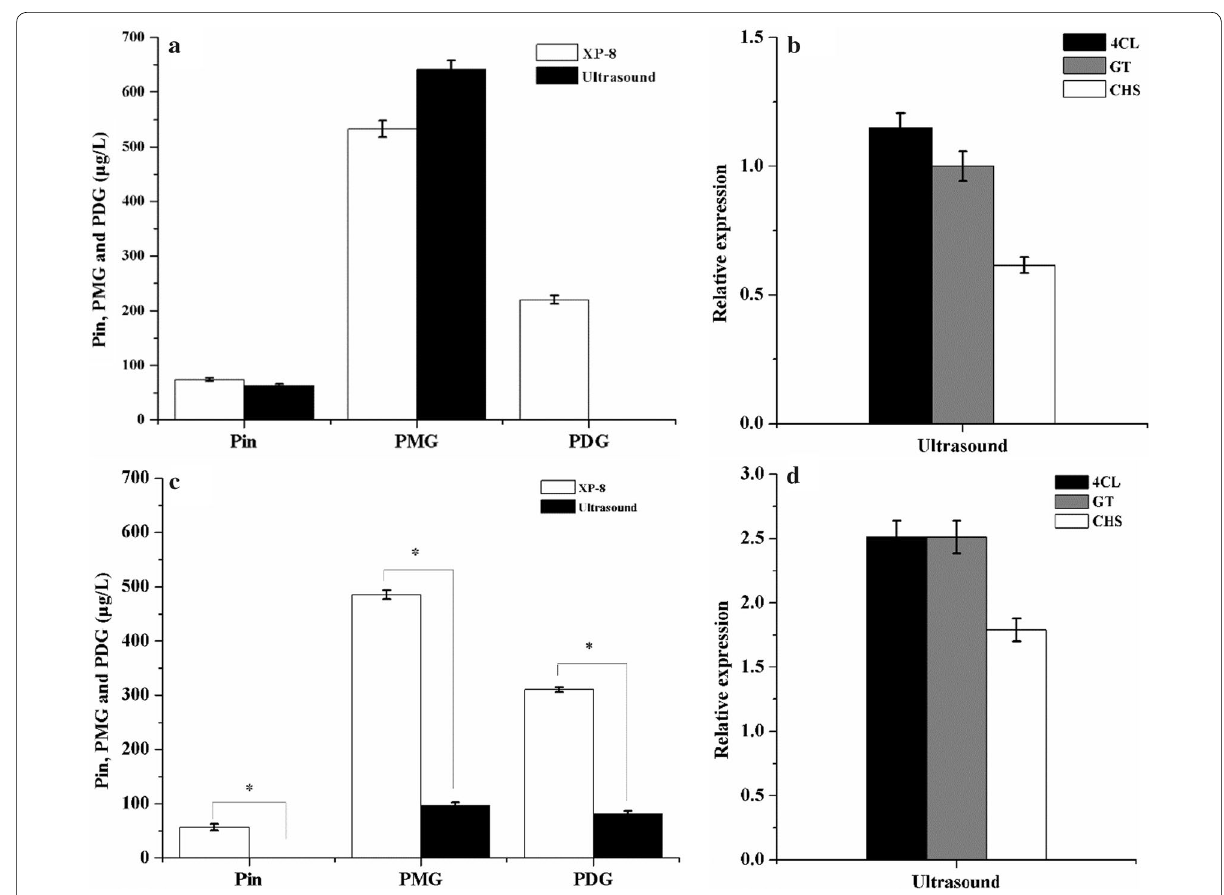
Fig. 5 Output of target products and gene expression levels obtained using ultrasound treatment in the systems with PDB medium ( a , b ) and the treated resting cells ( c , d